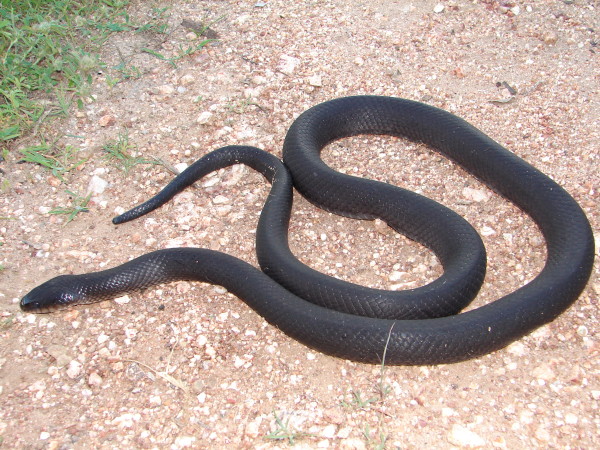
Boiruna sertanejaZaher, 1996 (Photo - Washington Vieira).